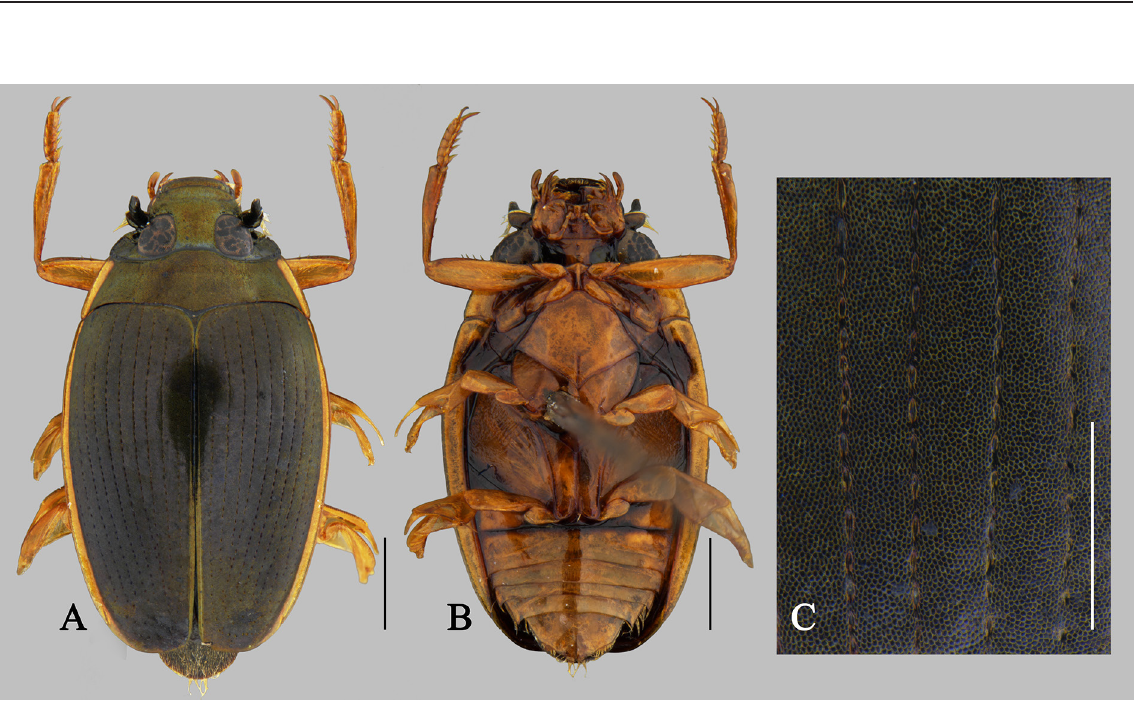
Fig. 7. Metagyrinus vitalisi (Peschet, 1923), ♀ (IZCAS). A . Habitus, dorsal view. B . Habitus, ventral view. C . Inner rows of elytral striae. Scale bars: A–B = 1 mm; C = 0.5 mm.